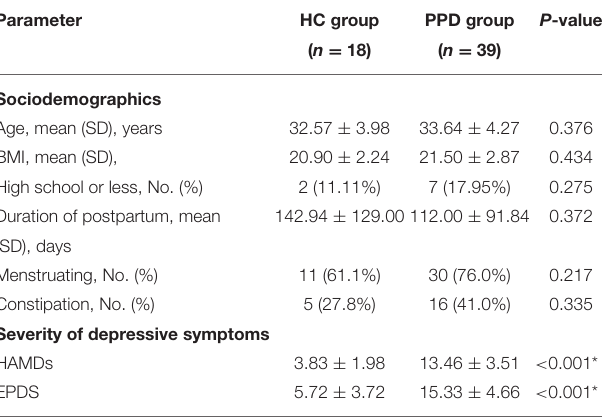
TABLE 1 | Baseline characteristics and clinical symptoms in patients with PPD and